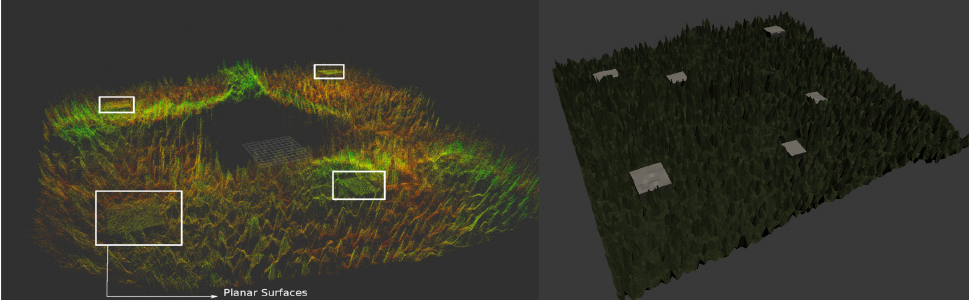
Figure 8. Second scenario point cloud and Blender